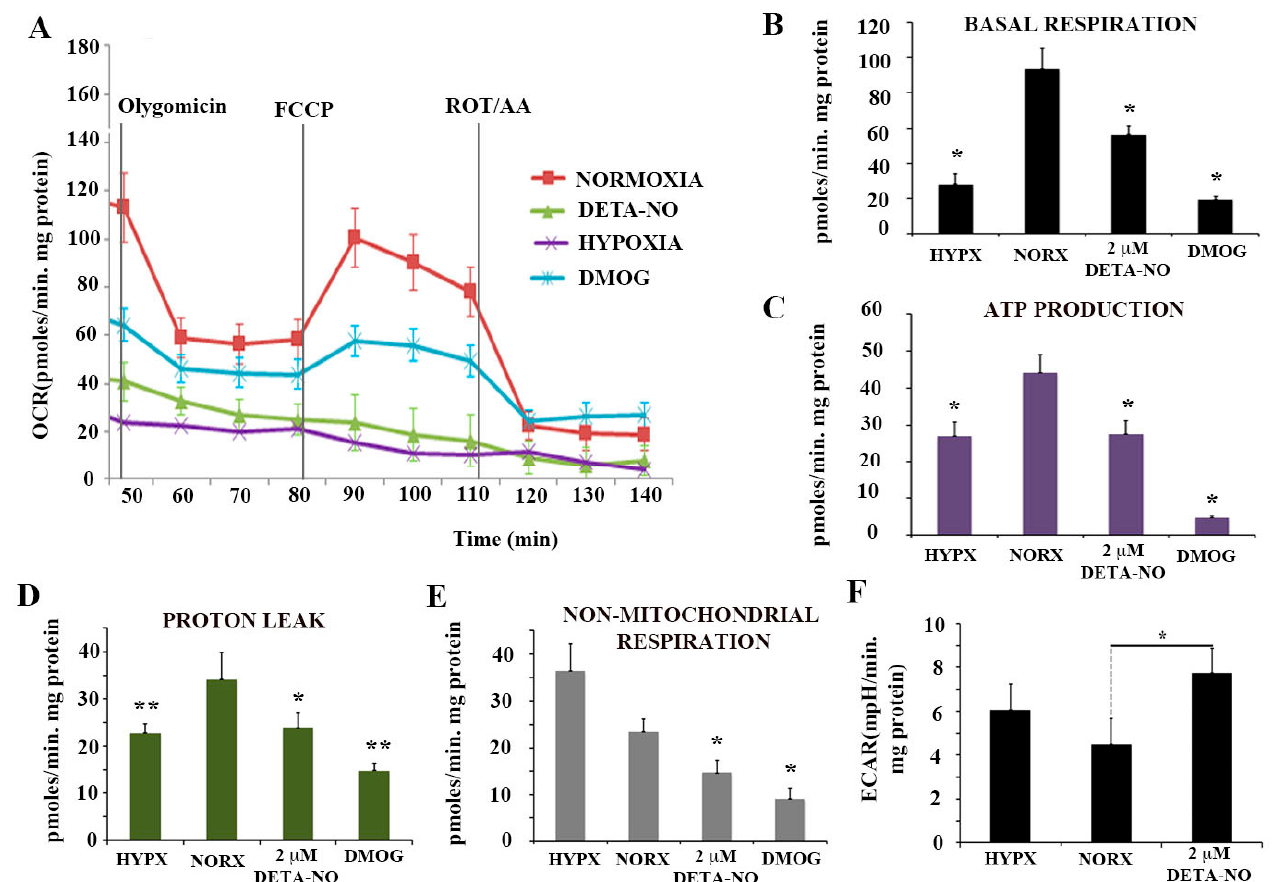
Figure 5. Nitric oxide effects on mitochondrial function. ( A ) Determination of the O2 consumption rate (OCR) in hESCs exposed to hypoxia for 48 h, to 2 µM DETA-NO under normoxia, and to 1 mM DMOG for 4 h in normoxia. Oligomycin (6 µM), FCCP (0.3 µM) and ROT (0.1 µM) + AA (0.1 µM) were added sequentially. ( B ) Basal respiration. ( C ) Production of ATP. ( D ) Proton leakage. ( E ) Non-mitochondrial respiration. The results represent the mean of 2 experiments ± SEM, with at least 5 replicates for each experimental condition. ( F ) Determination of extracellular acidification rate (ECAR) in hESCs. The results represent the mean of 5 independent experiments ± SEM. (*) p < 0.05. HIPX (Hypoxia); NORX (Normoxia). (*) p < 0.05; (**) p < 0.005. HIPX (Hypoxia); NORX (Normoxia); FCCP Carbonylcyanide-4-(trifluoromethoxy)phenylhydra- zone); DETANO Diethylenetriamine/nitric oxide adduct; DMOG Dimethyloxaloylglycine; ROT (Rotenone); AA (Antimy- cin A).